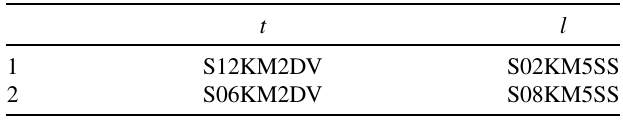
TABLE IV. Elements of SIS18 used for the second proof of principle experiment.